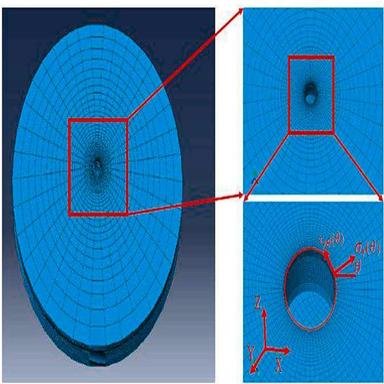
Calculation of calibration coefficients for residual stress evaluation using a finite element analysis (FEA) model in ABAQUS software. The images highlight local mesh refinement in the direct vicinity of the drilled hole and imposed loads at the hole boundary using cylindrical coordinates. Recompiled from.